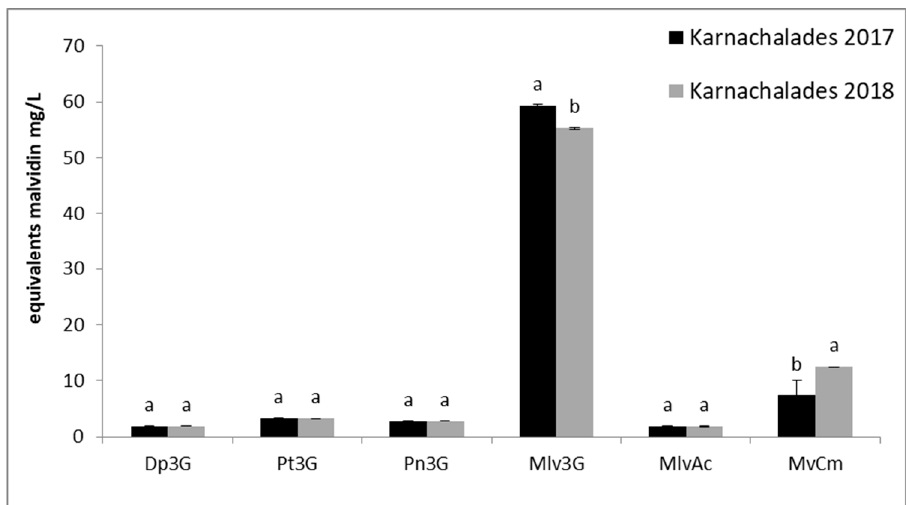
Figure 4. Individual anthocyanins evaluated by HPLC in “Karnachalades” (a.) wines. Abbreviations: Dp3G, delphinidin–3– O –glucoside; Pt3G, petunidin–3– O –glucoside; Pn3G, peonidin–3– O –glucoside; Mlv3G, malvidin–3– O –glucoside; MlvAc, malvidin 3– O –acetate–glucoside; MvCm, malvidin 3– O –coumarate–glucoside. Error bars show the average standard error. Different letters indicate significant difference between the same compounds in two consecutive years at p < 0.05 according to t -test.